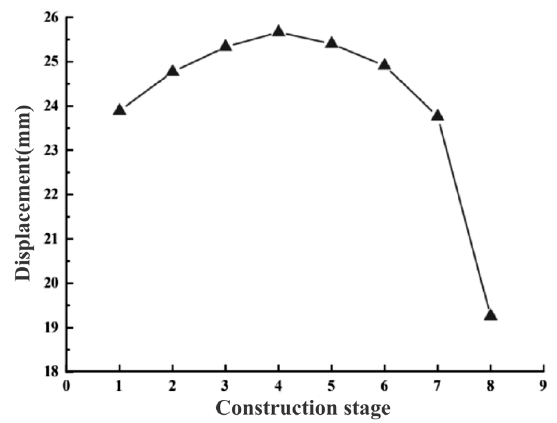
Figure 12. The maximum displacement changes in the structure.